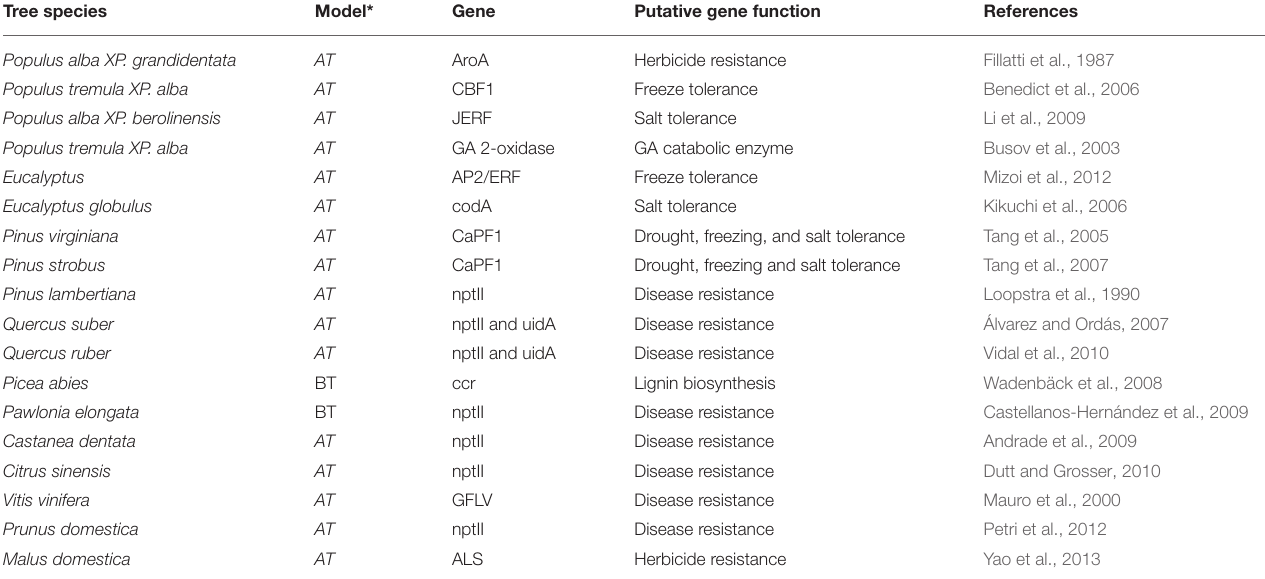
TABLE 1 | List of tree species successfully transformed genetically and potential candidates to be genome edited with CRISPR/Cas9. Tree